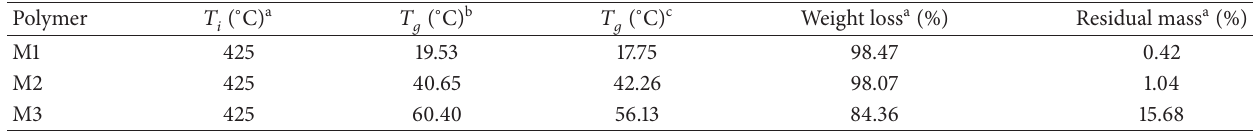
Table 1: Thermal analysis data for the prepared terpolymers.